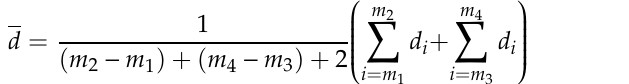
Figure 7. Amount of finger movement in each frame.